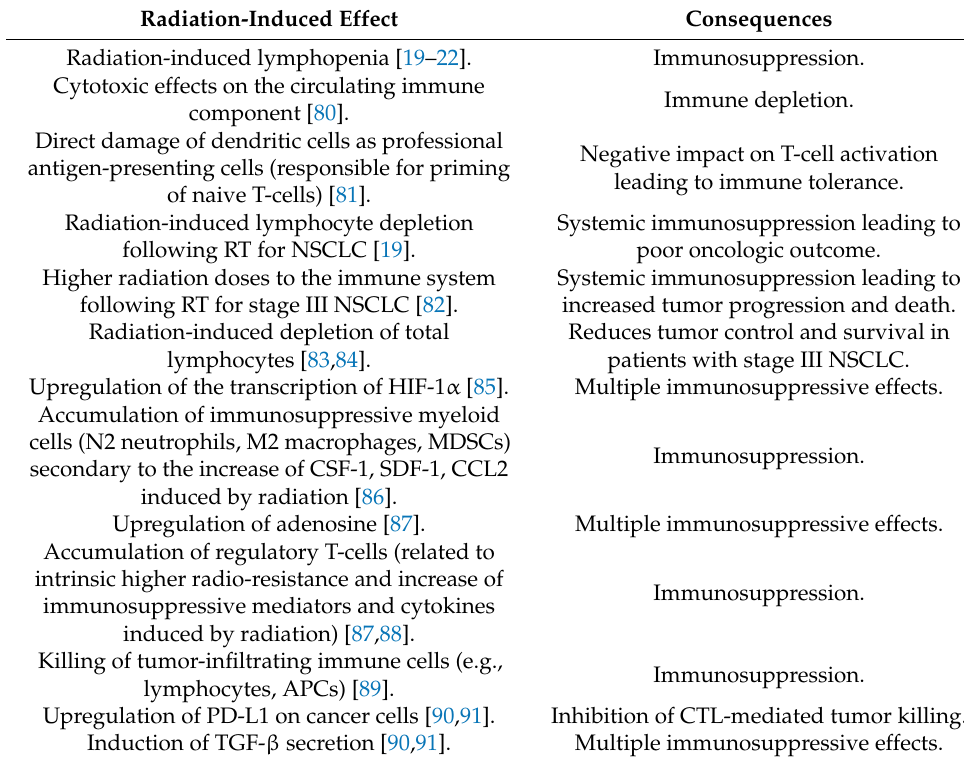
Table 2. Radiation-related immunosuppressive